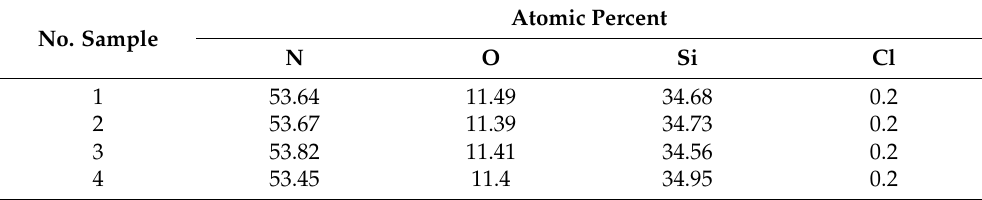
Table 1. Quantitative data on the elements content in the synthesized films.